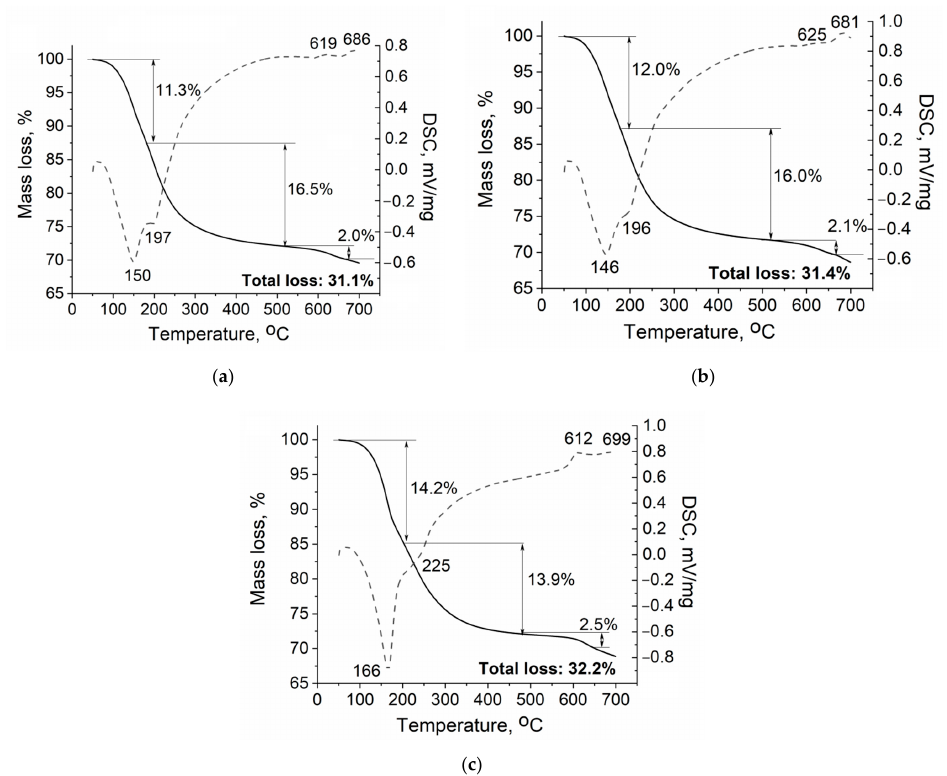
Figure 1. TG and DSC curves of the ( a ) CuAl-LDH-1 h, ( b ) CuAl-LDH-2 h and ( c ) CuAl-LDH samples. The endo-effects at the temperatures of 145–166 °C were assigned to removing of interlamellar water molecules. The second step at 195–225 °C was caused by dehydroxylation and decarbonization of interlayer carbonate. It should be noted that the endo-effect temperatures were shifted to higher values for the CuAl-LDH sample in comparison to that of the samples aged for 1 and 2 h, meaning that the carbonate ions were more strongly bound to the LDH structure. Additionally, the small exothermic peak at 612–625 °C could be related to the strongly bonded carbonates, which was confirmed by CO 2 evolving at 616 °C from the Cu-Zn-Al LDH catalyst precursor during thermal analysis coupled with mass spectrometer [33]. Thus, the calcination temperature of 650 °C was selected to exclude the presence of carbonate in the sample structure. All other samples aged for 4 h showed similar behavior as the CuAl-LDH sample during thermal analysis (the TA-DSC curves are not present in the paper). XRD was done for all samples dried at 110 ° C and calcined at 650 ° C. The characteristic peaks corresponding to the (00l) crystallographic planes of the copper aluminum hydrotalcite (PDF 046-0099) were observed for the sample dried at 110 ° C. The typical diffractogram was present for the CuAl-LDH sample (Figure 2a). The comparison of LDHs aged for 1, 2 and 4 h is presented on Figure 2b (low angle region). It can be seen